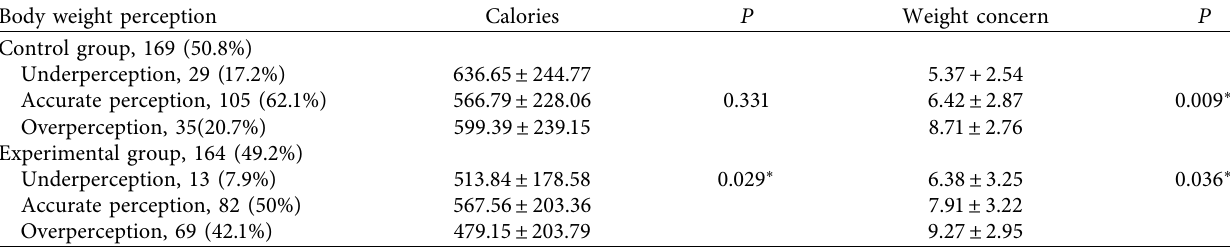
Table 3: The calorie intake and weight concern according to body weight perception among the groups ( N � 333). Body weight